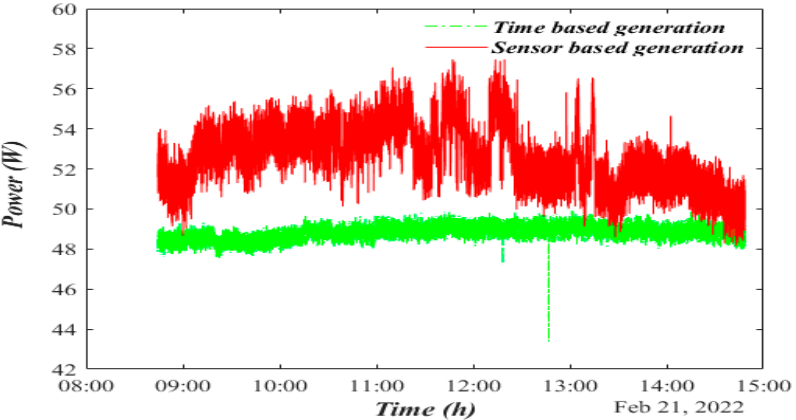
Figure 9. Power generation of the sensor-based system and the azimuth-based system.